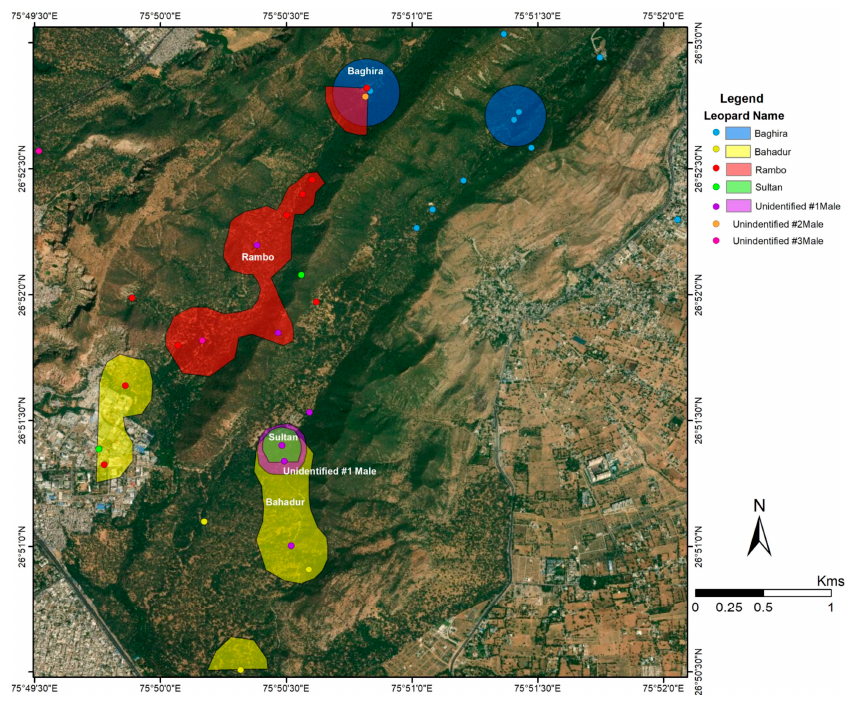
Figure 7. Kernel density analyses of 50% of clustered camera-trap photos of male leopards in Jhalana Forest